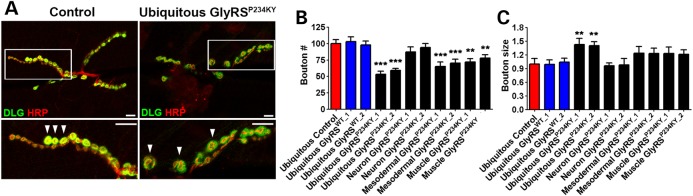
garsP234KY expression causes NMJ defects. NMJs consist of boutons that grow in lines resembling beads on a string (arrowheads, A). Nerves were visualized with anti-HRP (red) and the post-synaptic apparatus with anti-DLG (green). (A) Representative NMJs from muscles 6 and 7 of control (1032-GAL4) and ubiquitous garsP234KY (1032-GAL4; UAS-garsP234KY) larvae at the late L3 stage. (B) Ubiquitous, mesodermal (how-GAL4) and muscle (MHC-GAL4) expression of garsP234KY caused a reduction in bouton number. (C) Ubiquitous, mesodermal and muscle expression also lead to an increase in bouton size. Neuronal garsP234KY expression (elav-GAL4) caused no overt synaptic phenotype. For all graphs, *P < 0.05, **P < 0.01, ***P < 0.001 Bonferroni's/Dunn's multiple comparison test. At least 20 larvae were scored per NMJ. Scale bars = 10 µm.